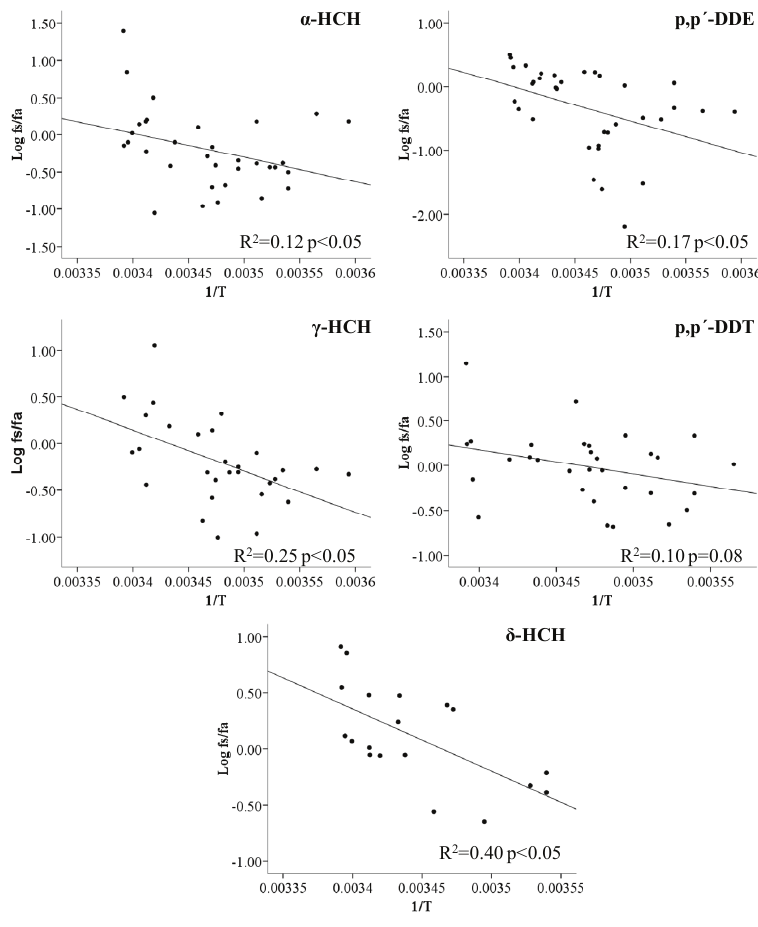
Fig. 5. Examples of soil to air fugacity ratio (Log f s / f a ) regressed against 1/ T